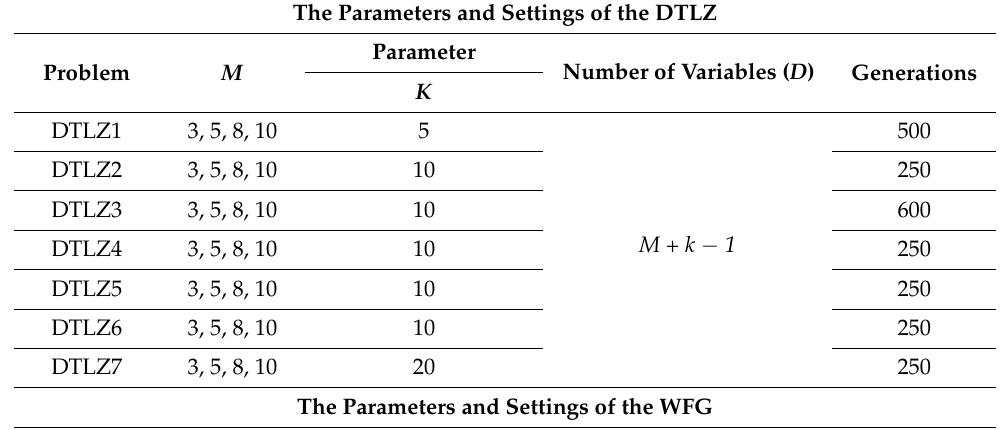
Table 1. Parameters and settings of the DTLZ and WFG problem